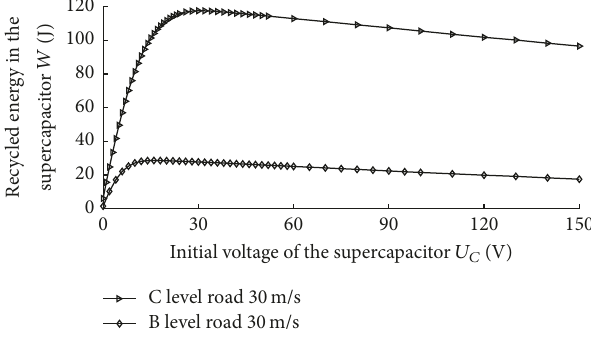
Figure 2: The relationship between recycled energy by the superca- pacitor and the initial terminal